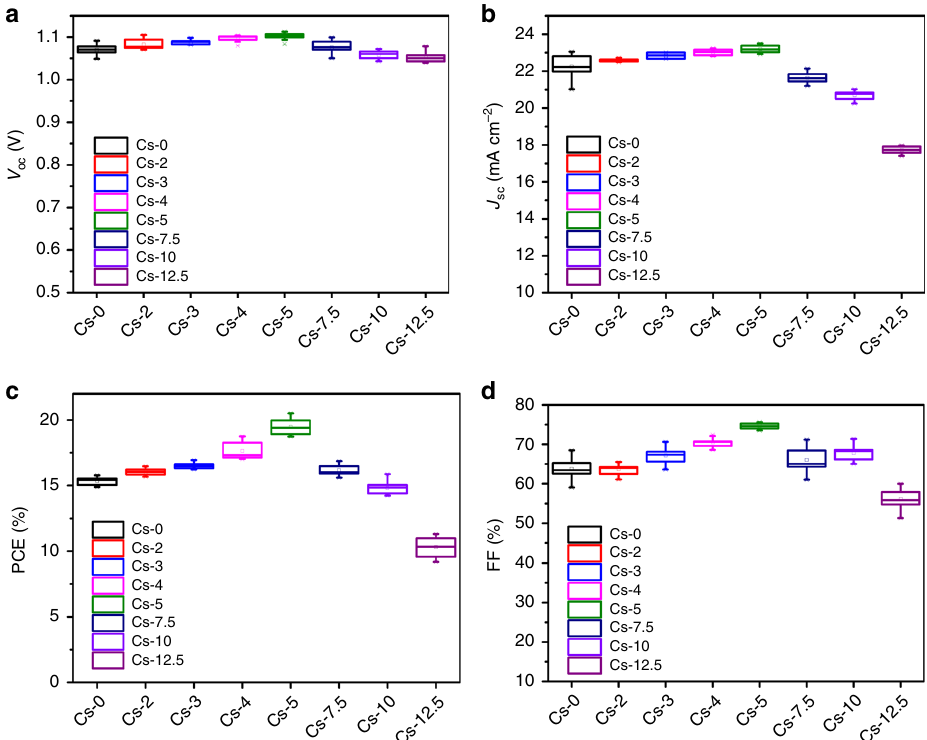
Fig. 4 Statistics of photovoltaic parameters. Statistics of I – V performance parameters: V oc ( a ), J sc ( b ), PCE ( c ), FF ( d ) for devices based on mixed FAMA perovskites with different cesium-doping concentration. Twelve devices for each Cs + -doping concentration were involved in the